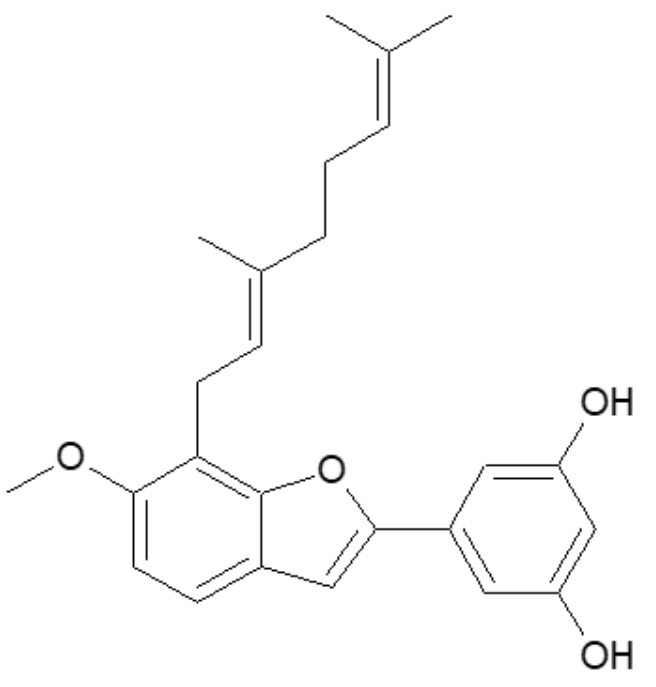
Figure 1. The structure of mulberrofuran B.